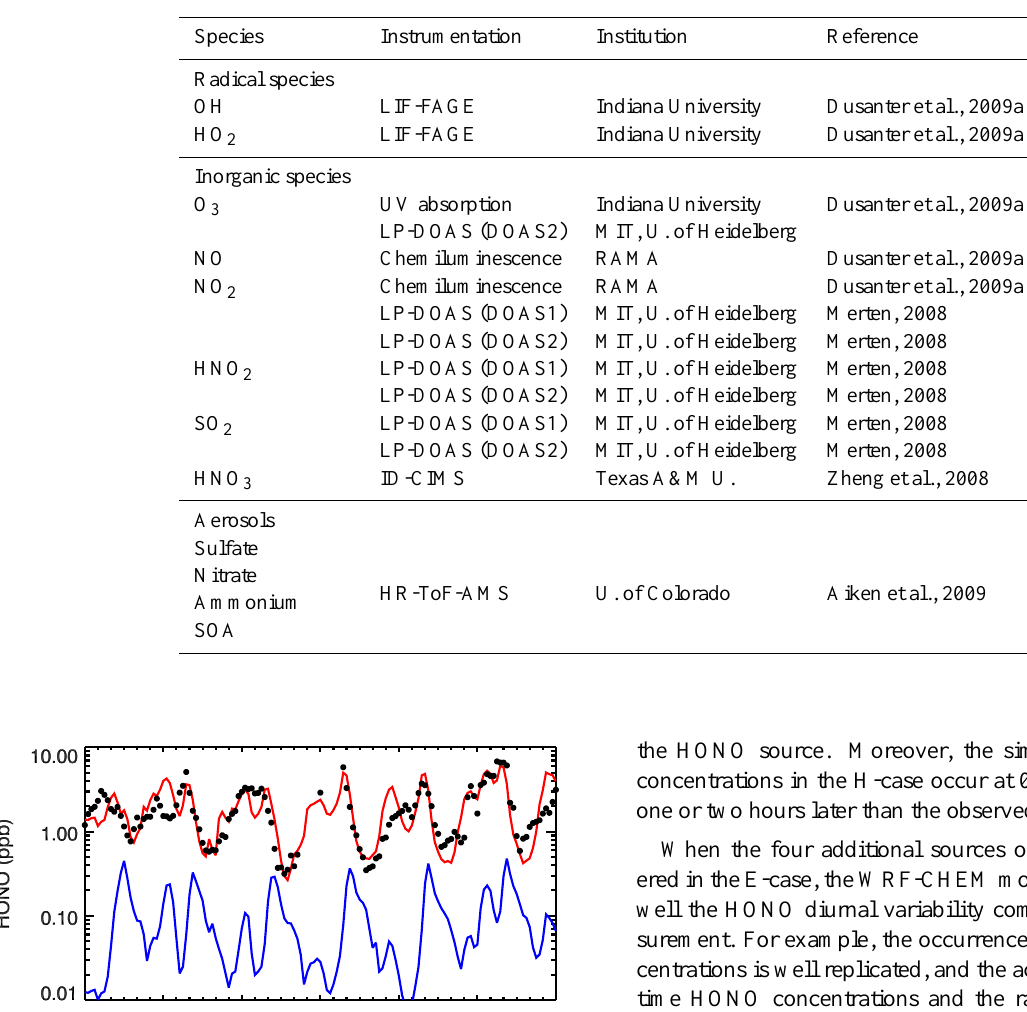
Table 1. Species used for comparison with simulations at T0.